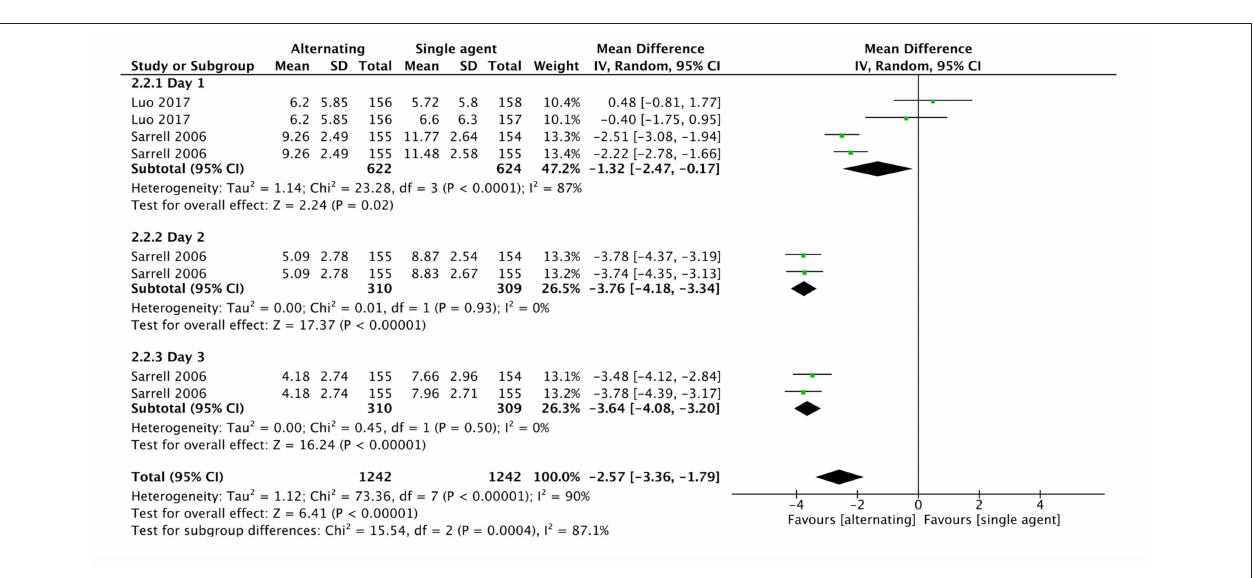
FIGURE 7 | Comparison: alternating vs. single agent, Outcome: NCCPC